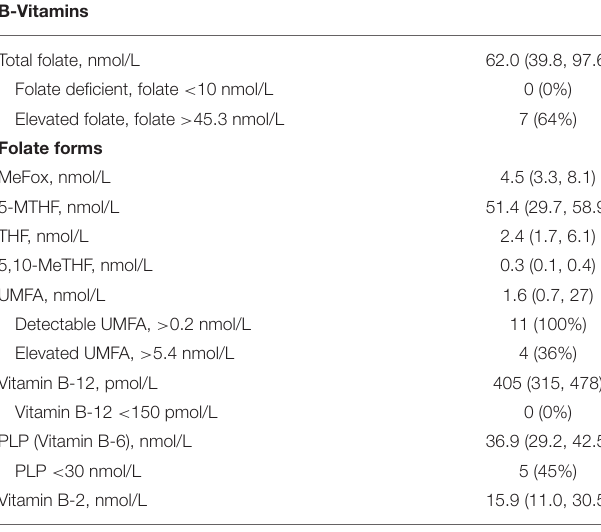
TABLE 2 | B-vitamin biomarkers of 11 children with sickle cell disease a,b